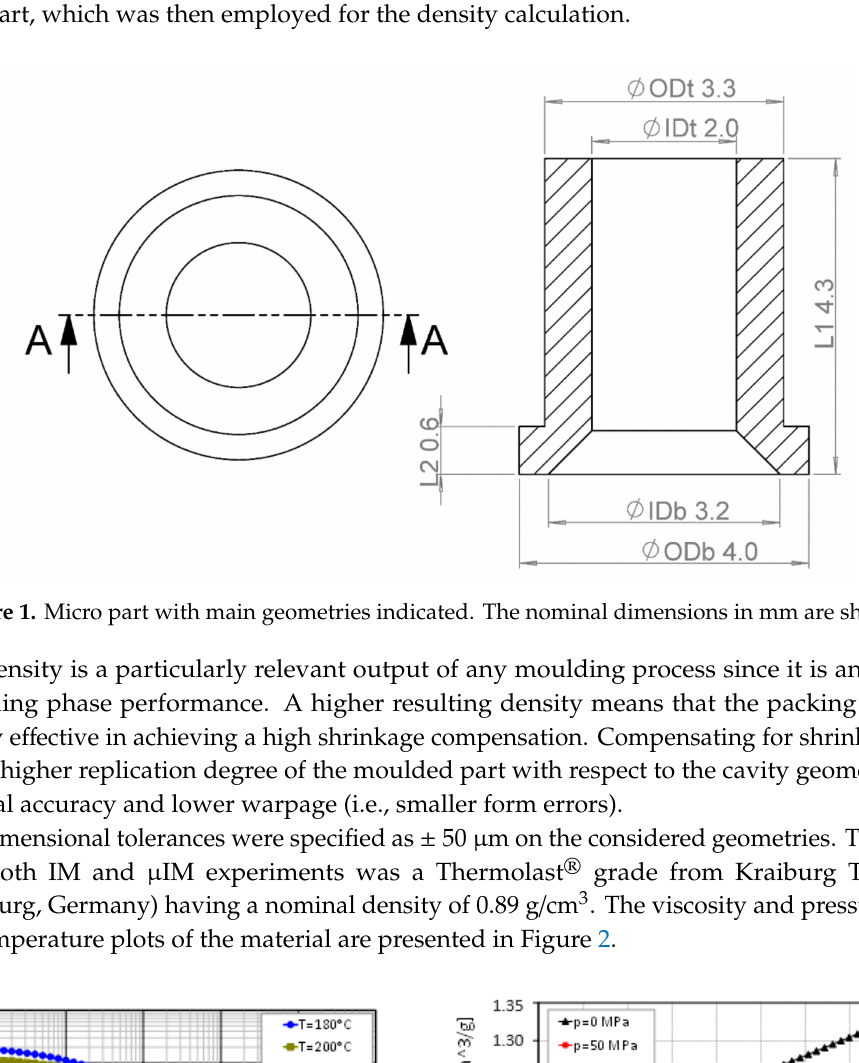
Figure 1. Micro part with main geometries indicated. The nominal dimensions in mm are shown.